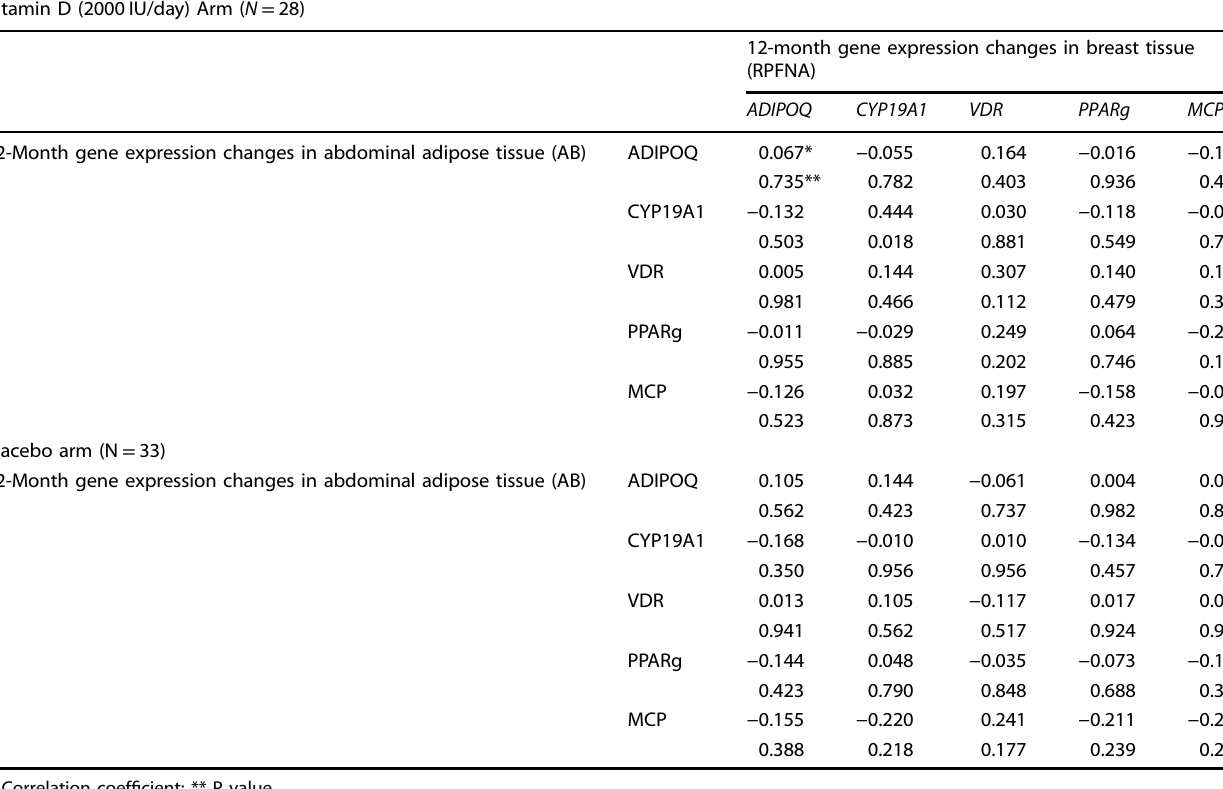
Table 3. Associations (Pearson correlation coef fi cients) between 12-month changes in gene expression in RPFNA and abdominal adipose tissue Vitamin D (2000 IU/day) Arm ( N = 28)